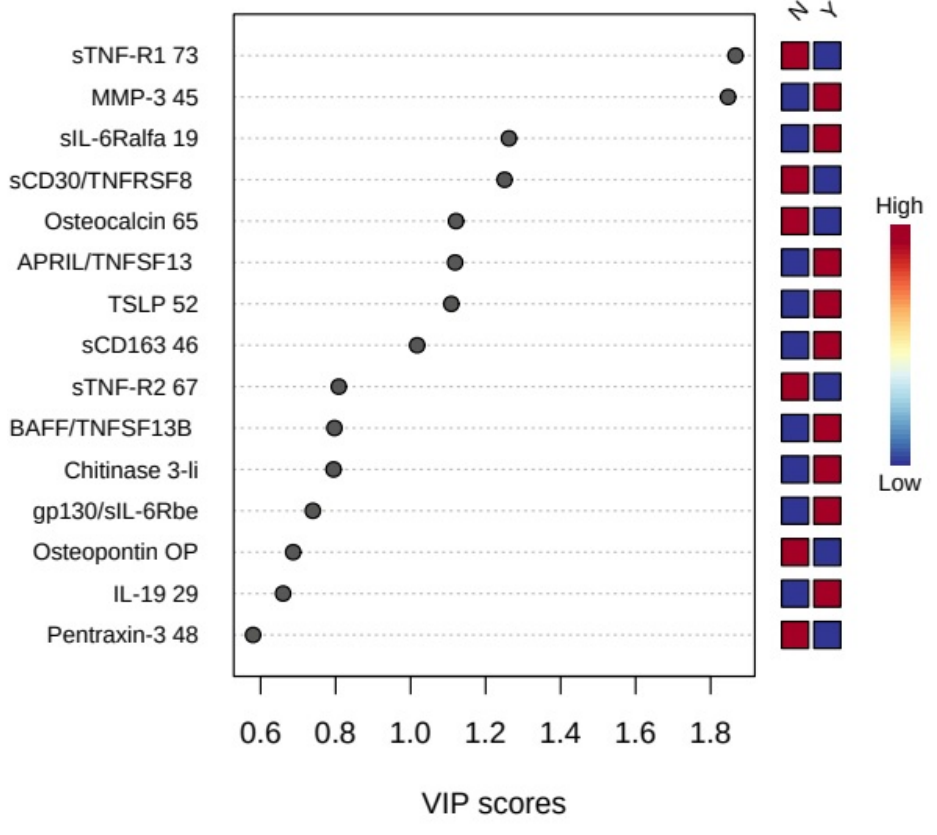
Figure 5. Important features identified by Partial-Least Squares Discriminant Analysis (PLS-DA). The colored boxes on the right indicate the relative concentrations of the corresponding metabolite in each group under study. N—control group; Y—study group.